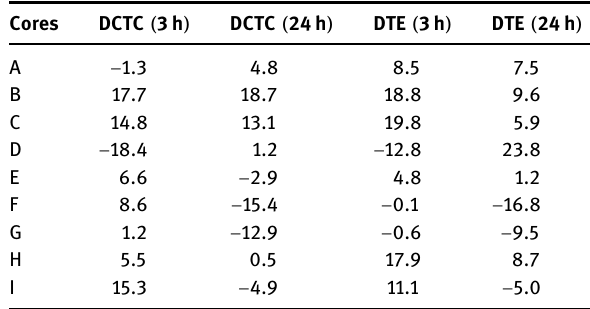
Table 4: Relative contribution of structural cores on anticonvulsant activity of terpenoids and their